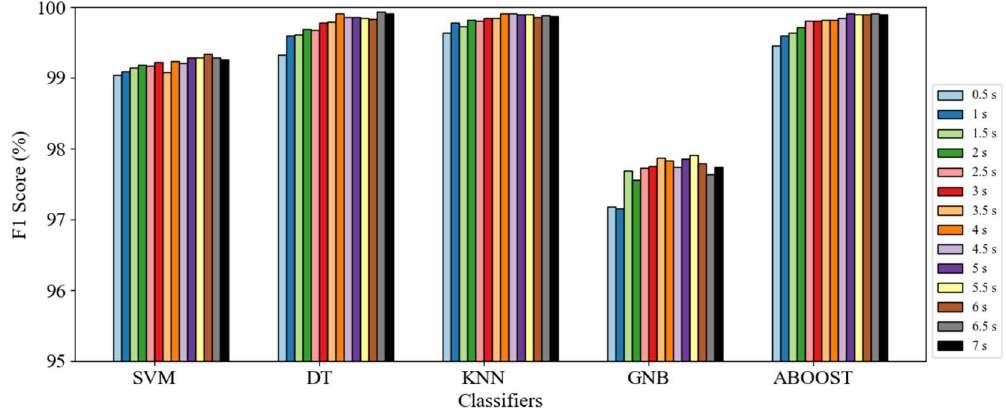
( c ) Figure 8. Distribution of compressed features of human poses with different window lengths: ( a ) 1 s; ( b ) 2 s; and ( c ) 3 s. 4.2.1. Global Evaluation In Figure 9, we compare the pose classification performance of each methodology with different window lengths. Each bar cluster represents different machine-learning methods, and bars in each